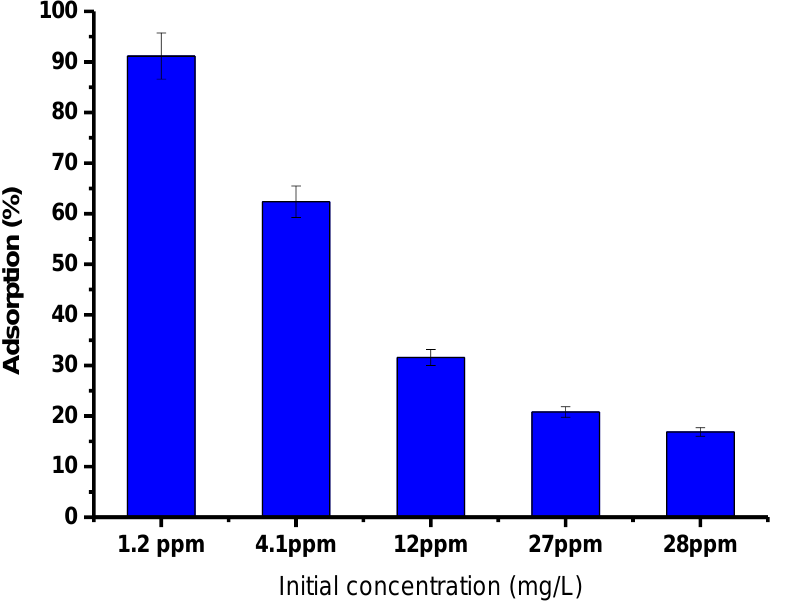
Figure 9. Effect of initial concentration of dye PTZs on adsorption by GO-date Seeds (T: 298K, pH: 9, Adsorbent dosage: 0.05 g/ L Contact time: 30 min).